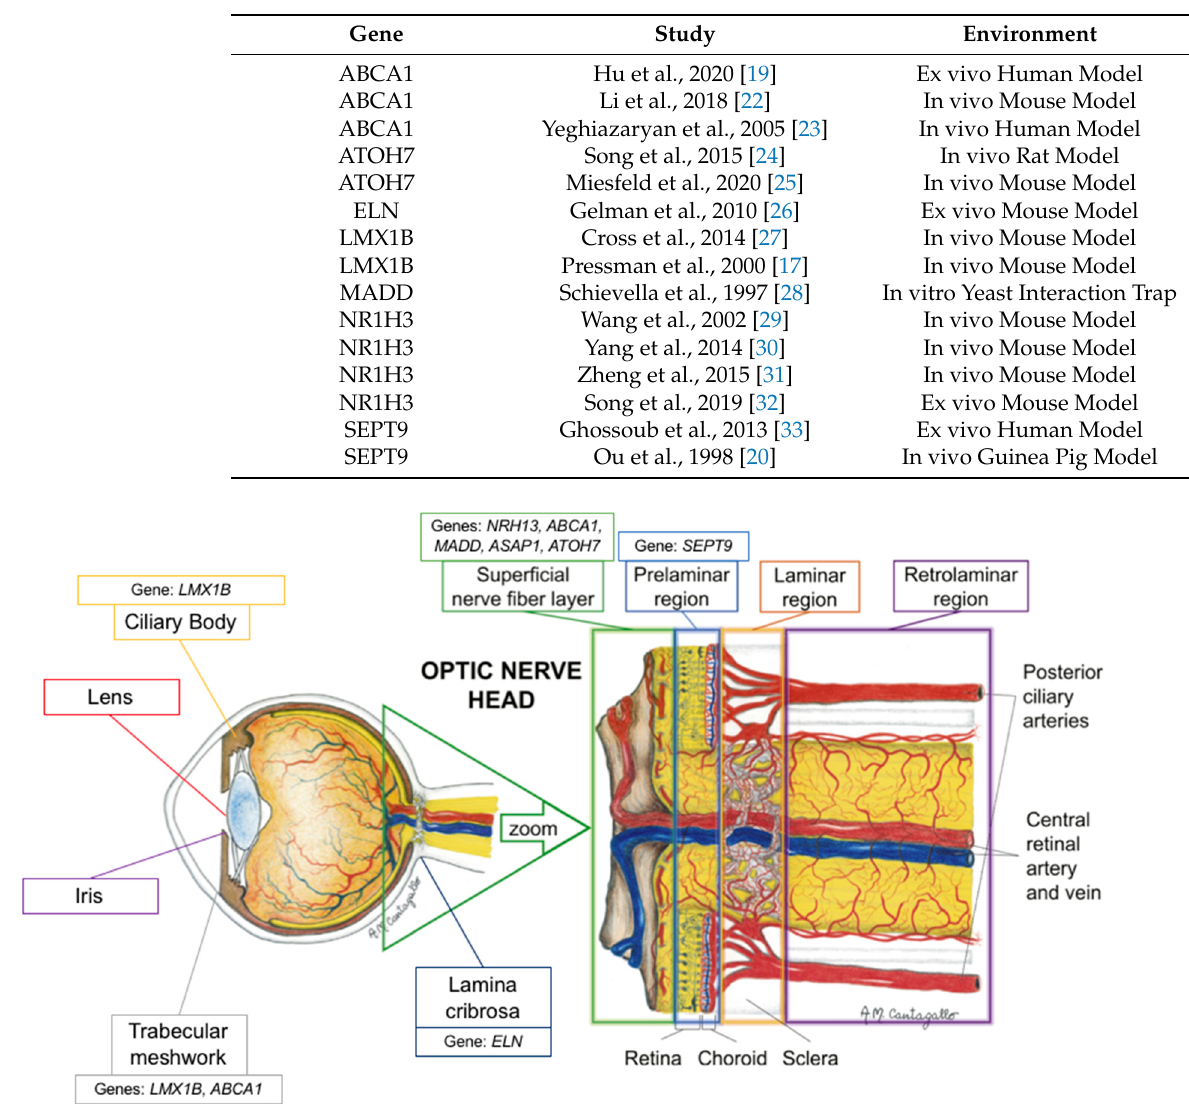
Figure 1. Schematic representation of the proposed location of the genes’ mechanism of action (adapted with permission from: Prada D, Harris A, Guidoboni G, Siesky B, Huang AM, Arciero J. Autoregulation and neurovascular coupling in the optic nerve head. Survey of Ophthalmology 1 March 2016; 61(2):164–186).